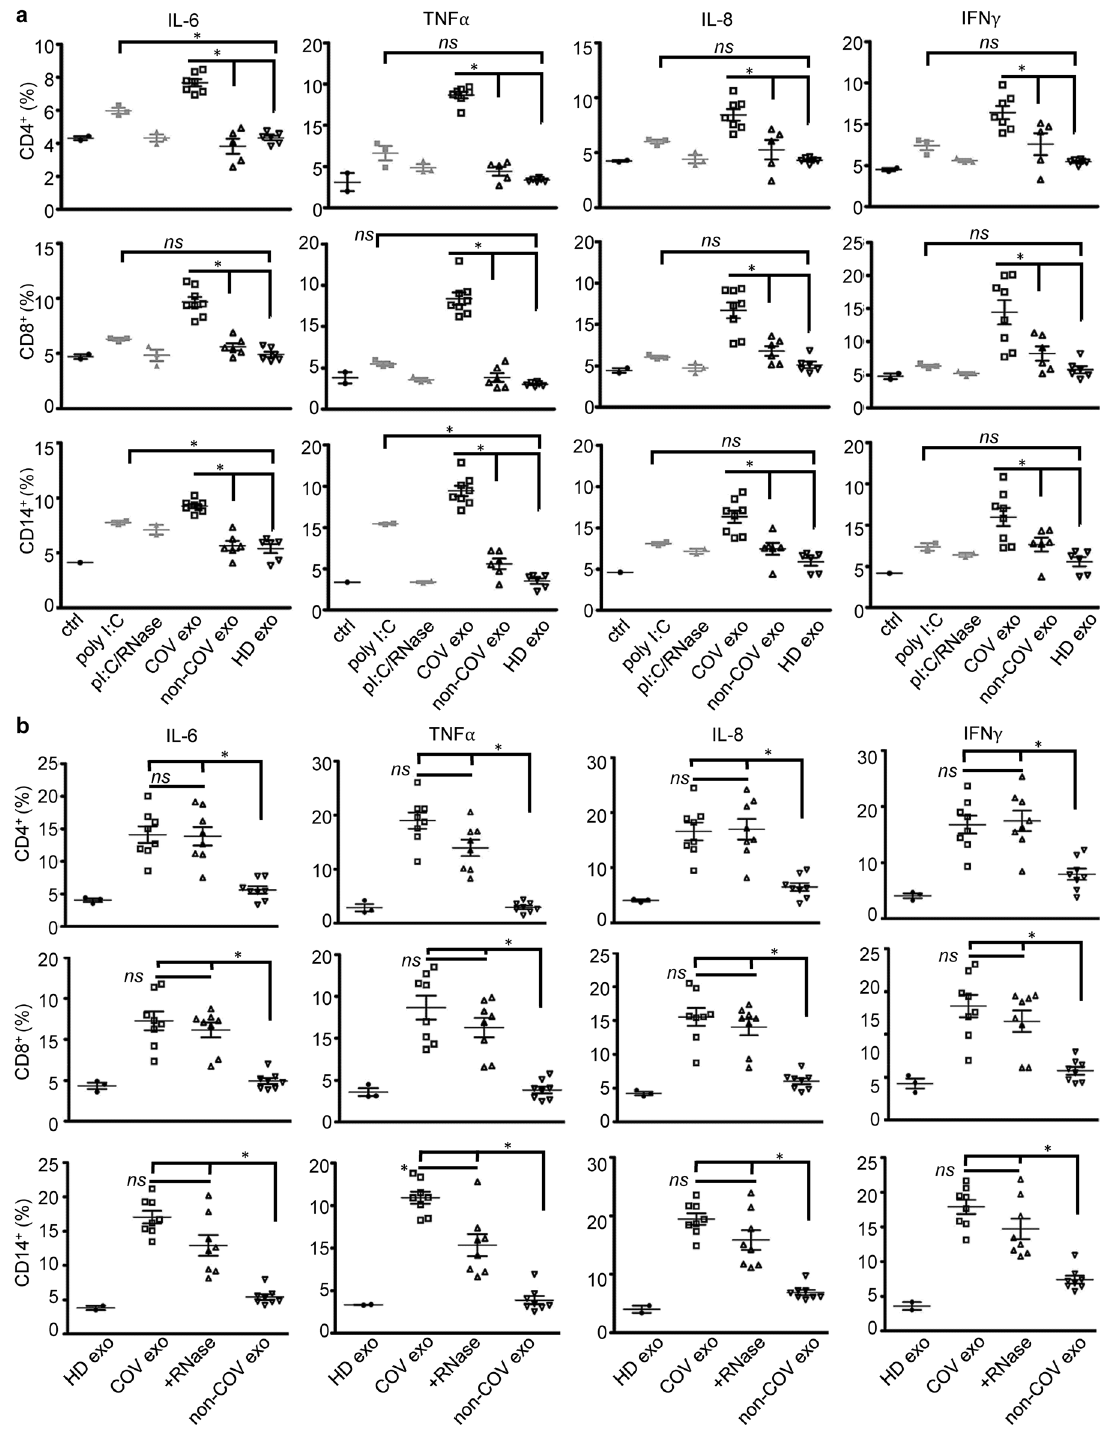
Figure 5. Production of cytokines in response to plasma exosomes and RNase. ( a ) CD4 + T cells, CD8 + T cells, and CD14 + monocytes were separated from PBMCs using MicroBeads, followed by treatment with plasma exosomes (4 × 10 9 ml −1 ) from COVID-19 patients upon admission (COV exo, n = 8), non-COVID donors (non- COV exo, n = 6), healthy donors (HD exo, n = 5) as well as poly(I:C) (poly I:C, 5 µg ml −1 ) and poly(I:C) treated with RNase A (pI:C/RNase) in RPMI medium for 16 h at 37 °C. ctrl, medium only. Expression of cytokines was determined by flow cytometry gating on live cells. Data represent one experiment out of three repeats. Each flow cytometry assay was run in triplicate. Error bars, ± SD; * p < 0.05; ns , p > 0.05. One-way ANOVA. ( b ) COVID-19 plasma exosomes treated with an RNase (+ RNase, 50 µg ml −1 at 37 °C for 10 min) or remained untreated (COV exo) were used to stimulate PBMC for cytokine flow cytometry as in ( a ). Plasma exosomes from non-COVID (non-COV exo) and healthy donors (HD exo) were used as controls. Error bars, ± SD; * p < 0.05; ns , p > 0.05; one- way ANOVA. Graphs shown representative results from three biological repeats. Isotype antibody controls and blank controls were performed in parallel in flow